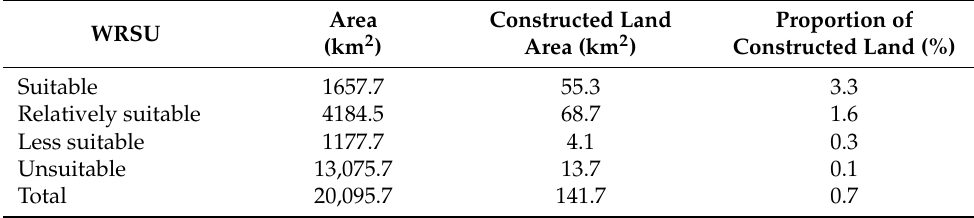
Table 4. The distribution of constructed land under different WRSU grades.